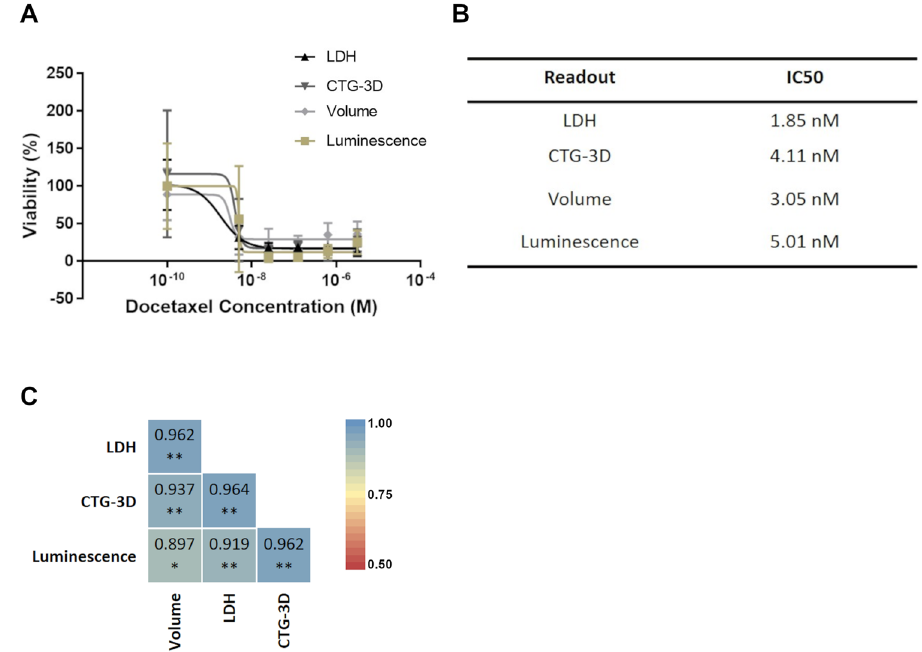
Figure 4. LDH assay can be used to assess DTX efficacy in xenosphere cultures. ( A ) DTX efficacy in xenosphere cultures was assessed via LDH, CTG-3D, and volume in NCI-H1650 xenospheres or luminescence in NCI-H1650.LMC xenospheres. ( B ) IC50 values of DTX in the xenosphere cultures as determined by each readout method, ( C ) Pearson correlation coefficient between measured LDH content in the cultures after DTX treatment and luminescence, CTG-3D, and volume measurements (data is presented as mean ± SD of N = 5, * p < 0.05 ** p <